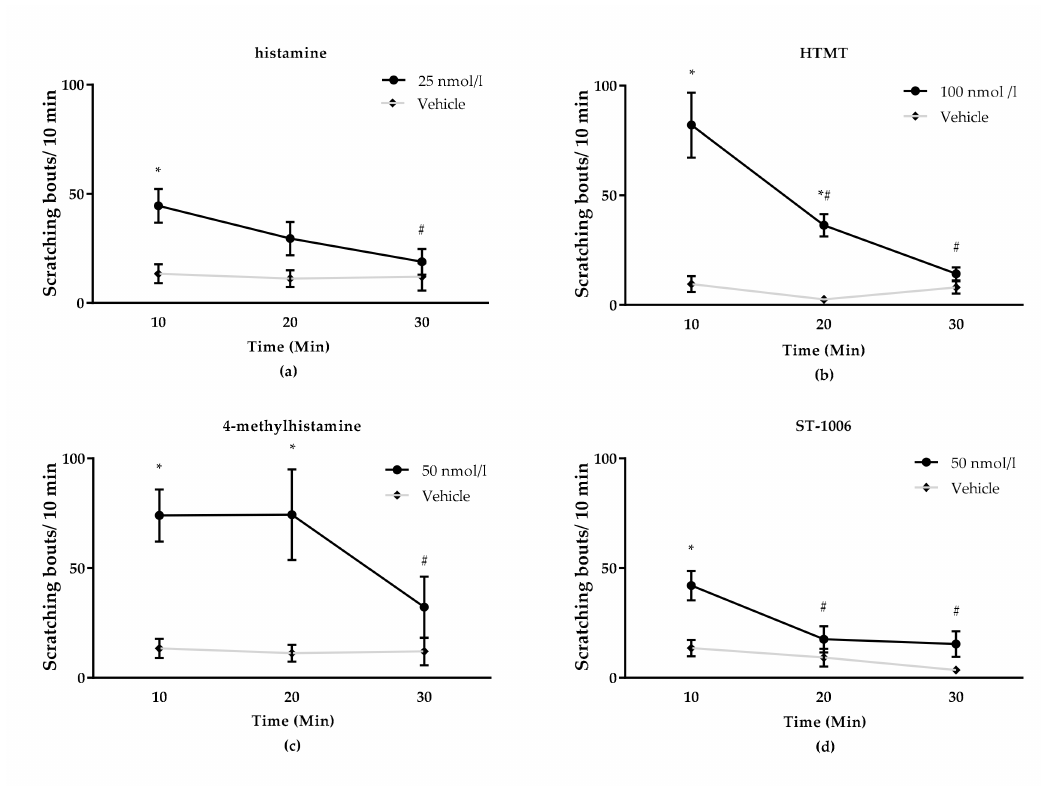
Figure 3. Scratching response time course over 30 min after intradermal injection (50 µ L) of histamine receptor agonists in CD-1 mice. All agonists induced a significantly increased scratching response in the first 10 min after application. HTMT- and 4-MH-induced itch returned to baseline level (vehicle control = 0.9% NaCl) at approximately 30 min after intradermal injection. For histamine- and ST-1006-induced itch, no significant difference was seen 20 min after injection. ( a ) Scratching response after 25 nmol/L histamine (all HR) injection. ( b ) Scratching response after 100 nmol/L HTMT (H1R/H2R) injection. ( c ) Scratching response after 4-MH (H2R/H4R) 50 nmol/L injection. ( d ) Scratching response after ST-1006 (H4R) 50 nmol/L injection. Results are presented as median ± SD. Two-way ANOVA: * p < 0.05 (factor treatment) = significantly different from vehicle (saline) injection, # p < 0.05 (factor time) = scratching response to pruritogen significantly different from 10 min